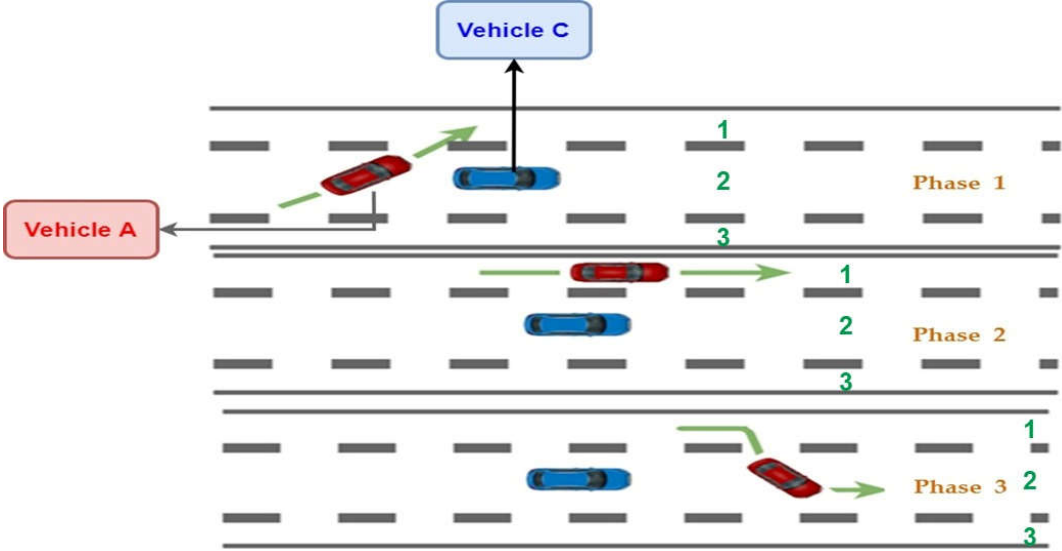
Figure 8. Scheme of overtaking-maneuver phases.